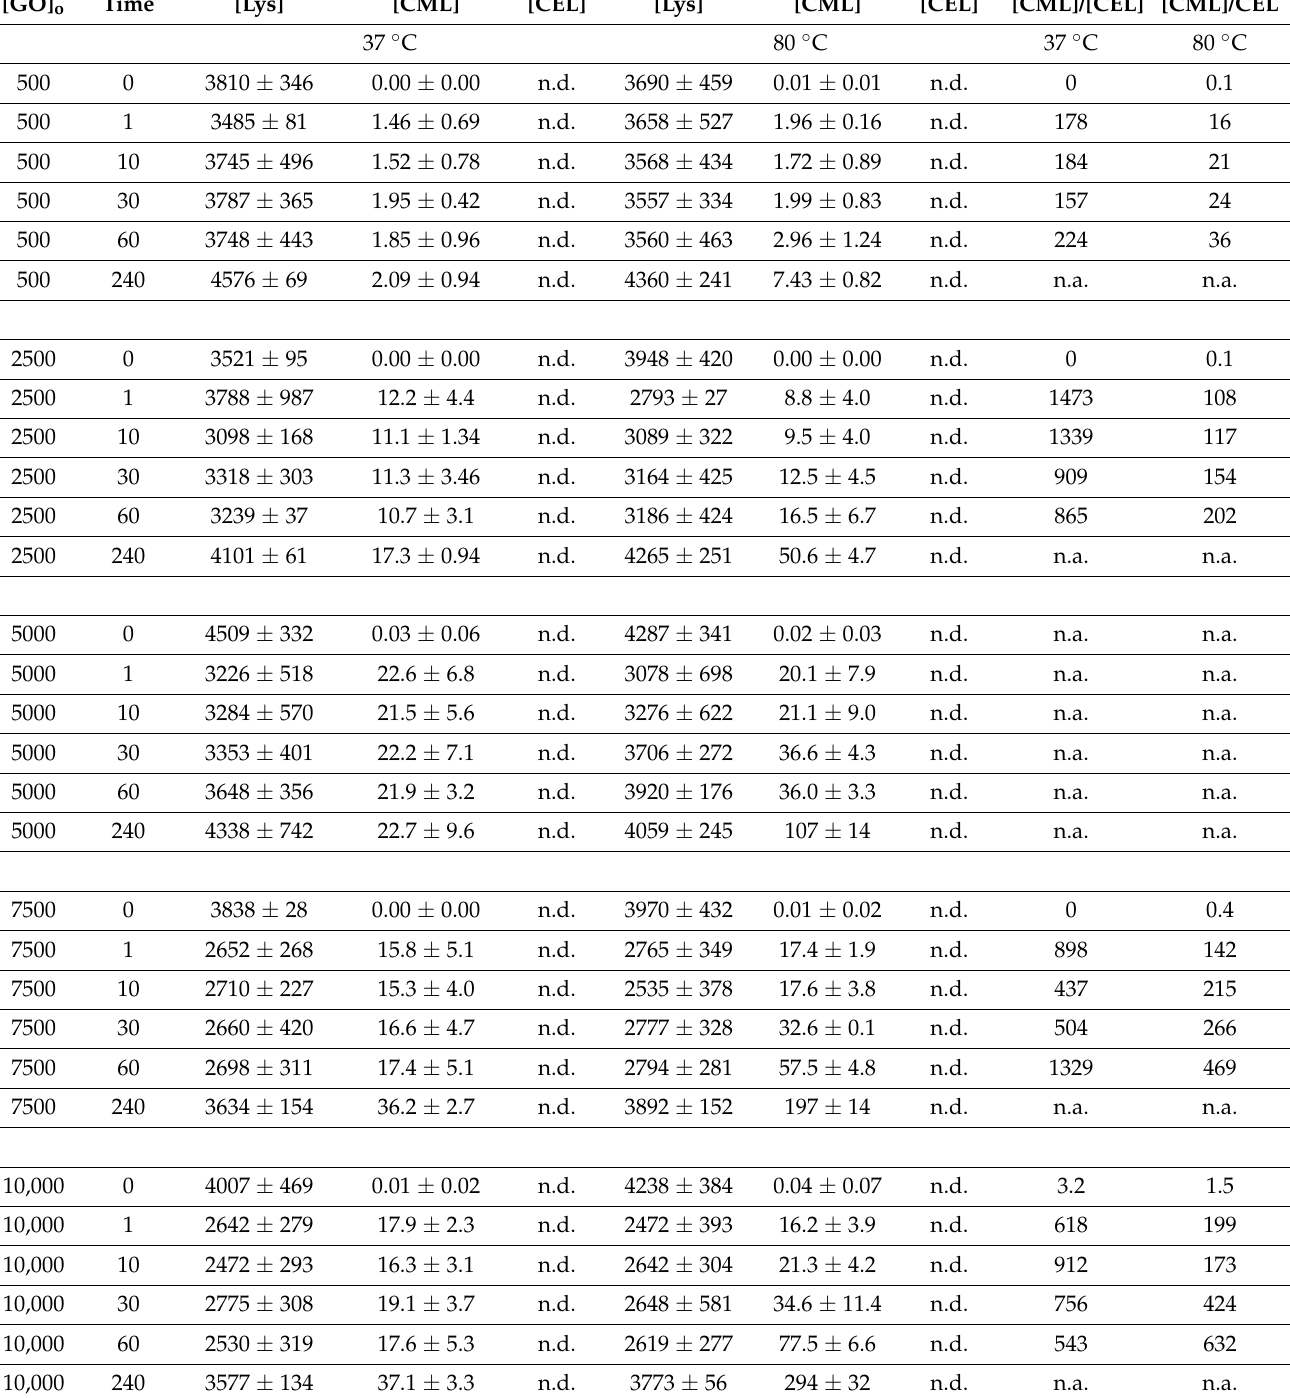
Table 4. Concentration (mean ± SD; µ M) of remaining Lys and formed CML and CEL from the reaction of Lys and GO at initial concentrations of 5000 µ M and 500–10,000 µ M, respectively, at 37 ◦ C and at 80 ◦ C for the indicated times (min) in 100 mM phosphate buffer (pH 7.4), and molar ratios